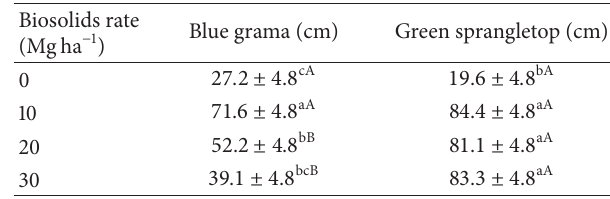
Table 4: Grass species height (mean ± SE) of blue grama ( Bouteloua gracilis ) and green sprangletop ( Leptochloa dubia ) under different biosolids rates at a seeded abandoned field in Chihuahua, Mexico.